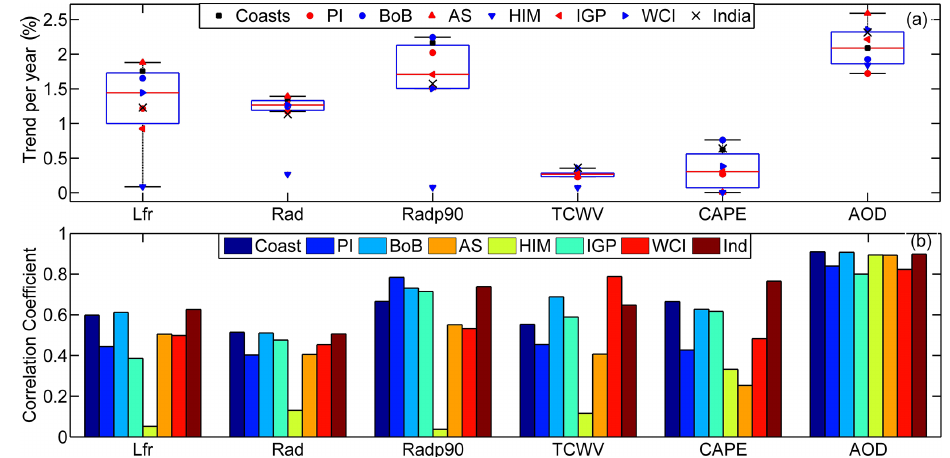
Figure 2. (a) Yearly trends (in percent) in lightning flash rate (Lfr), average radiance (Rad) and 90th percentile of radiance (Radp90) with TCWV, CAPE and AOD over seven regions and over the entire Indian region; (b) correlation coefficients corresponding to these trend